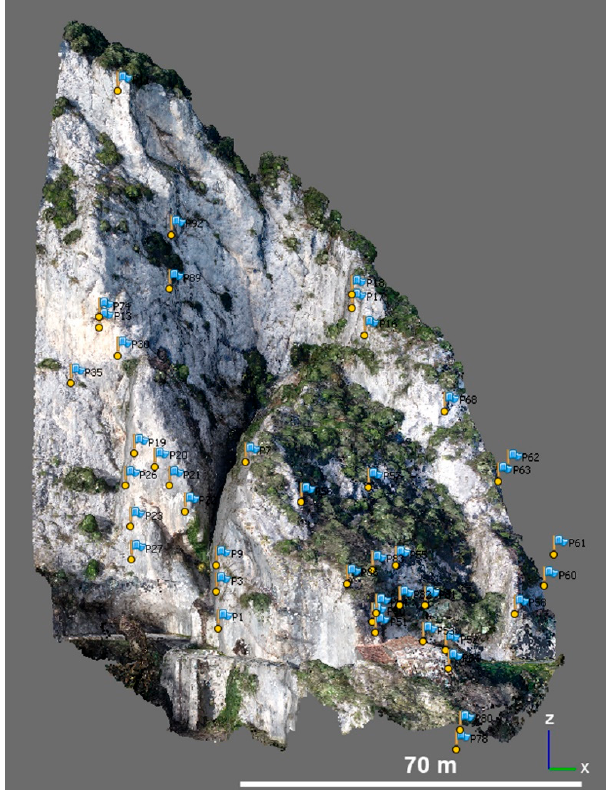
Figure 2. Perspective view, from SE, of Ground Control Point (GCP) spatial distribution along the slope (dense 3D textured point cloud in background).